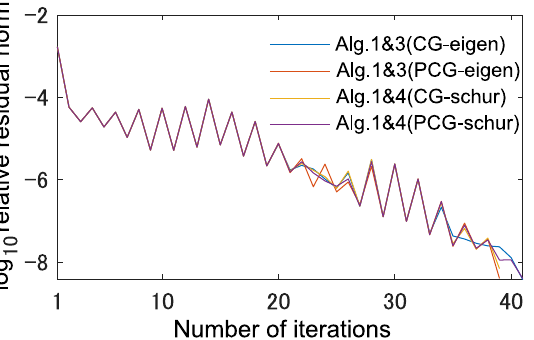
Figure 2. Convergence histories with relative residual norm of the Lanczos method for the median singular value of the almost symmetric matrix T whose size is n = 15.